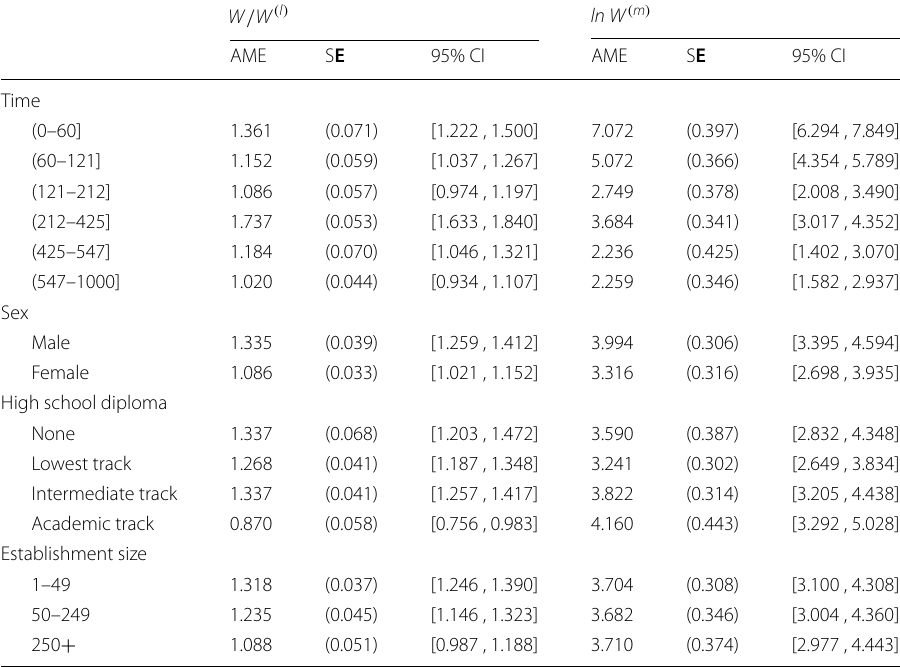
Table 4 Average marginal effects on the survival rate in % when accounting for interaction